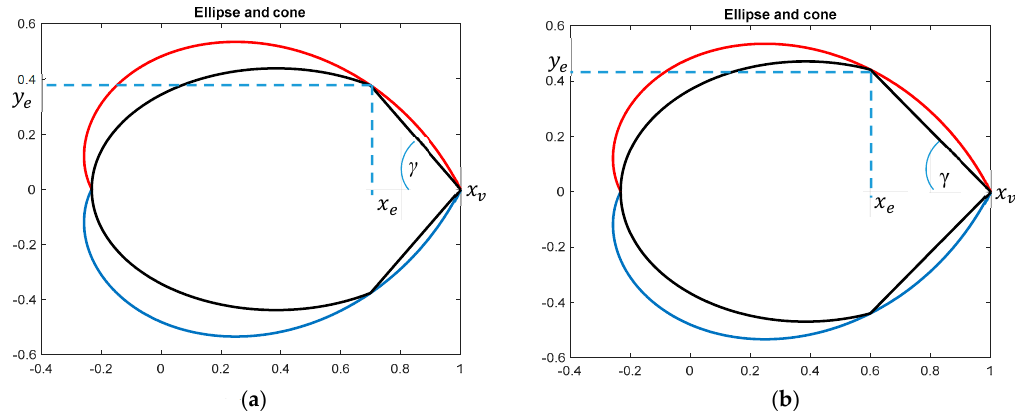
Figure 9. Approximation given by the intersection of the angle and ellipse ( a ) for 𝑥 (cid:3032) = 0.7 and ( b ) for 𝑥 (cid:3032) = 0.6 .